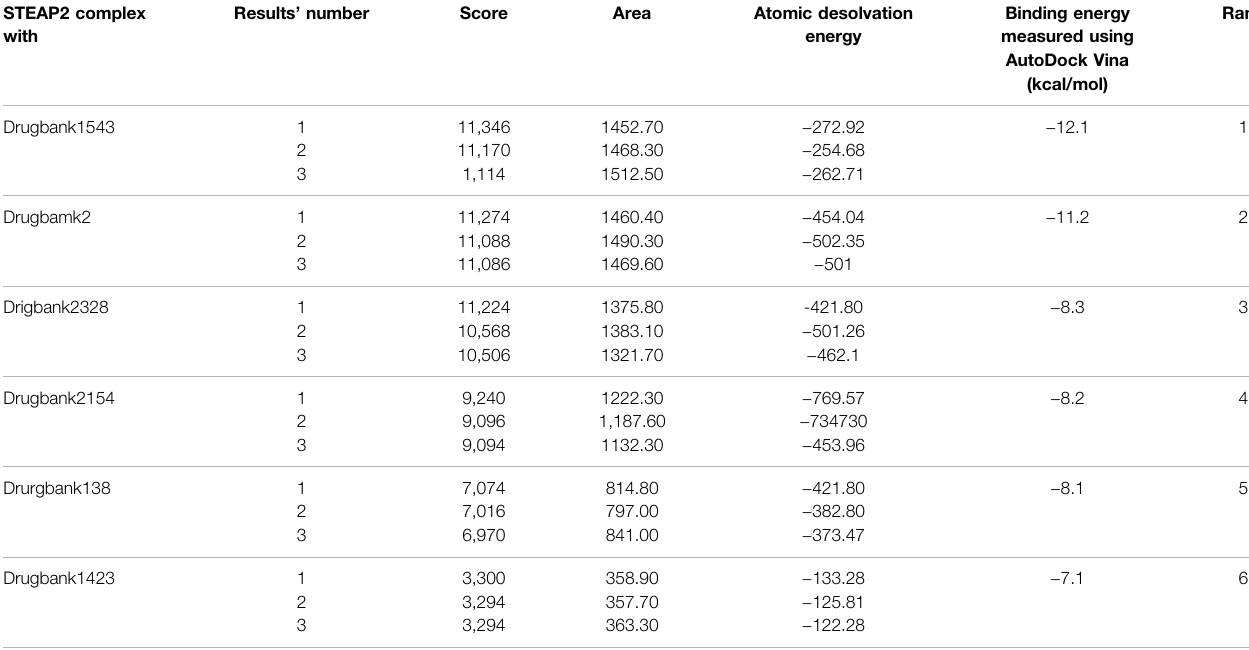
TABLE 5 | PatchDock docking evaluation of docking scores using AutoDock Vina. STEAP2 complex